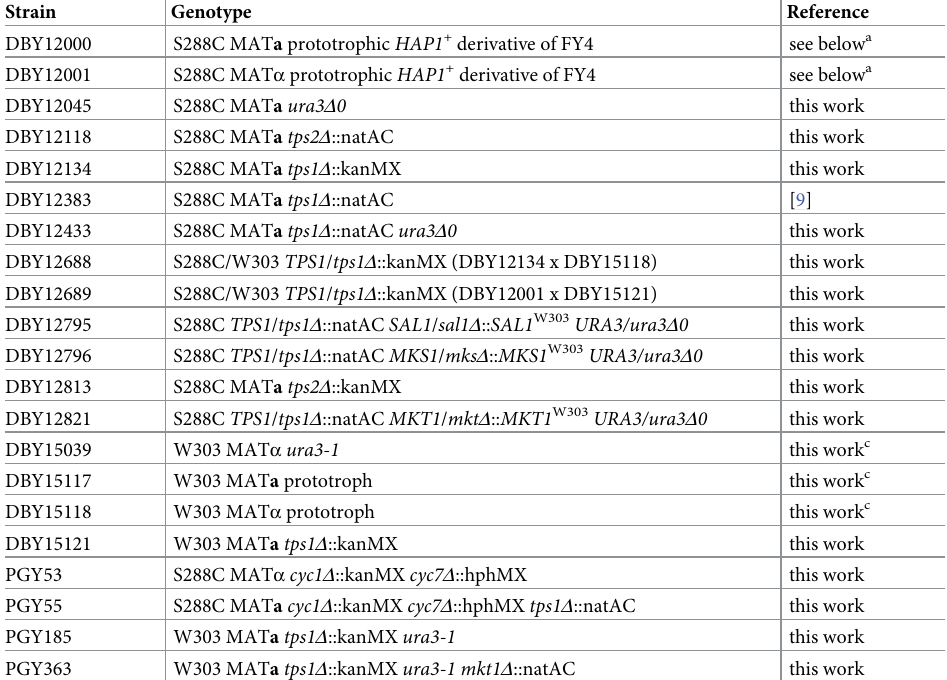
Table 1. Strains used in this